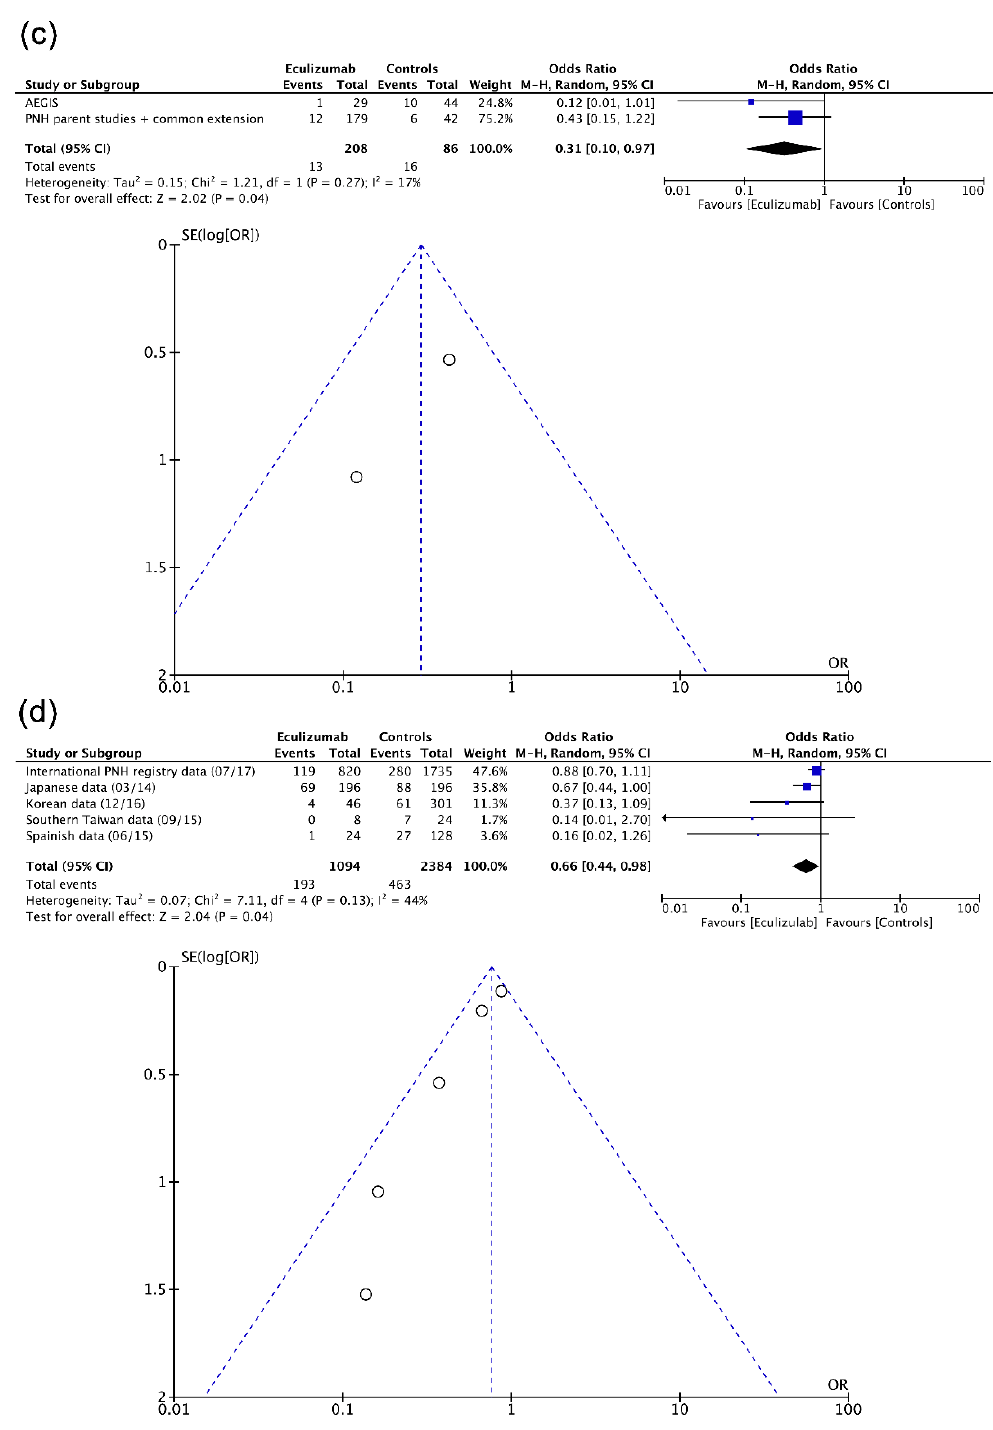
Figure 5. Forest and funnel plots showing effect estimates of eculizumab for ( a ) clinical trials and ( b ) real-life NRSI in thrombotic events in PNH, and for ( c ) clinical trials and ( d ) real-life NRSI in CKD apparition/progression in PNH. CI, confidence interval; CKD, chronic kidney disease; M–H, Mantel–Haenszel test; NRSI, non-randomized studies of the effects of interventions; PNH, paroxysmal nocturnal hemoglobinuria; SE, standard error.